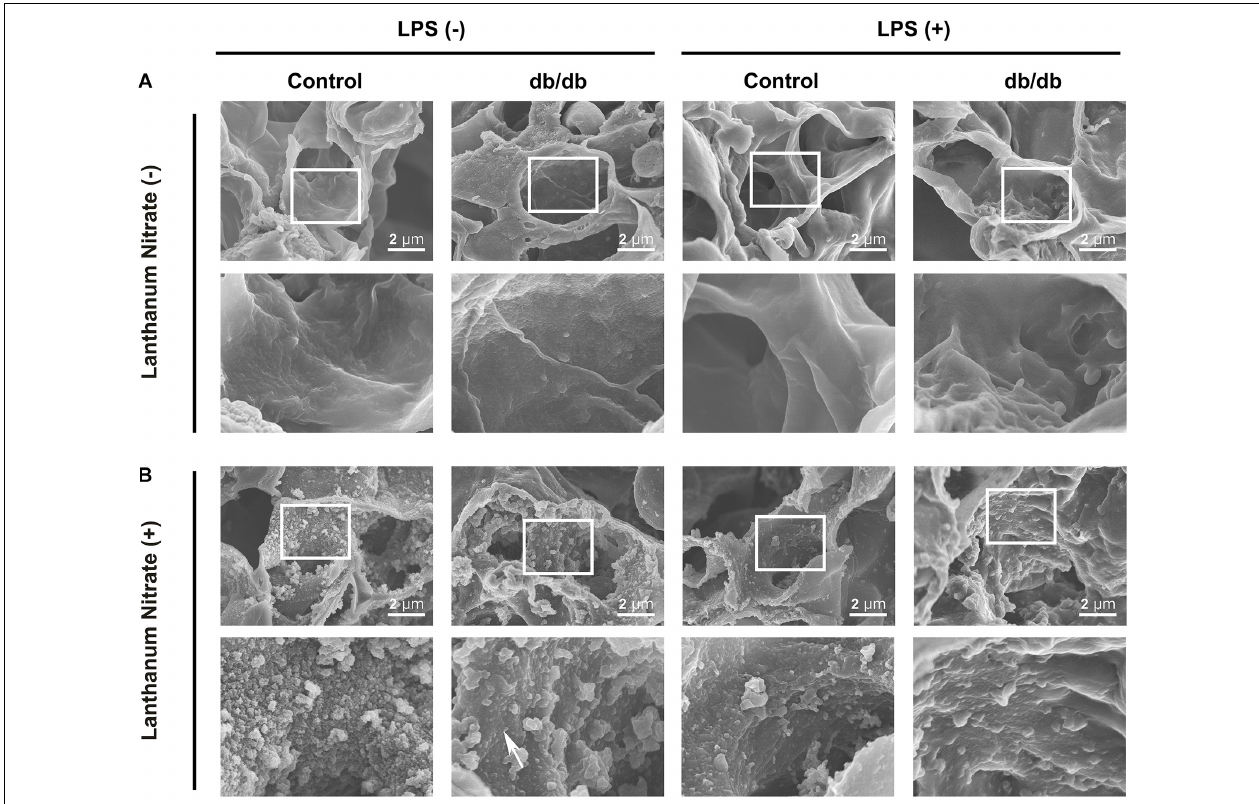
FIGURE 5 | Ultrastructural imaging of pulmonary endothelial injury by SEM. (A) Images for samples not stained with lanthanum nitrate; the endothelial glycocalyx was not detected . (B) The endothelial glycocalyx was detected using lanthanum nitrate staining. Although the moss-like structure of the endothelial glycocalyx covered the surface of the vascular endothelium in the control group mice under normal conditions, the endothelial glycocalyx structure was already degraded and dispersed (white arrow) in db/db mice. After LPS injection, the endothelial glycocalyx was degraded completely in db/db mice, whereas its injury was attenuated in control